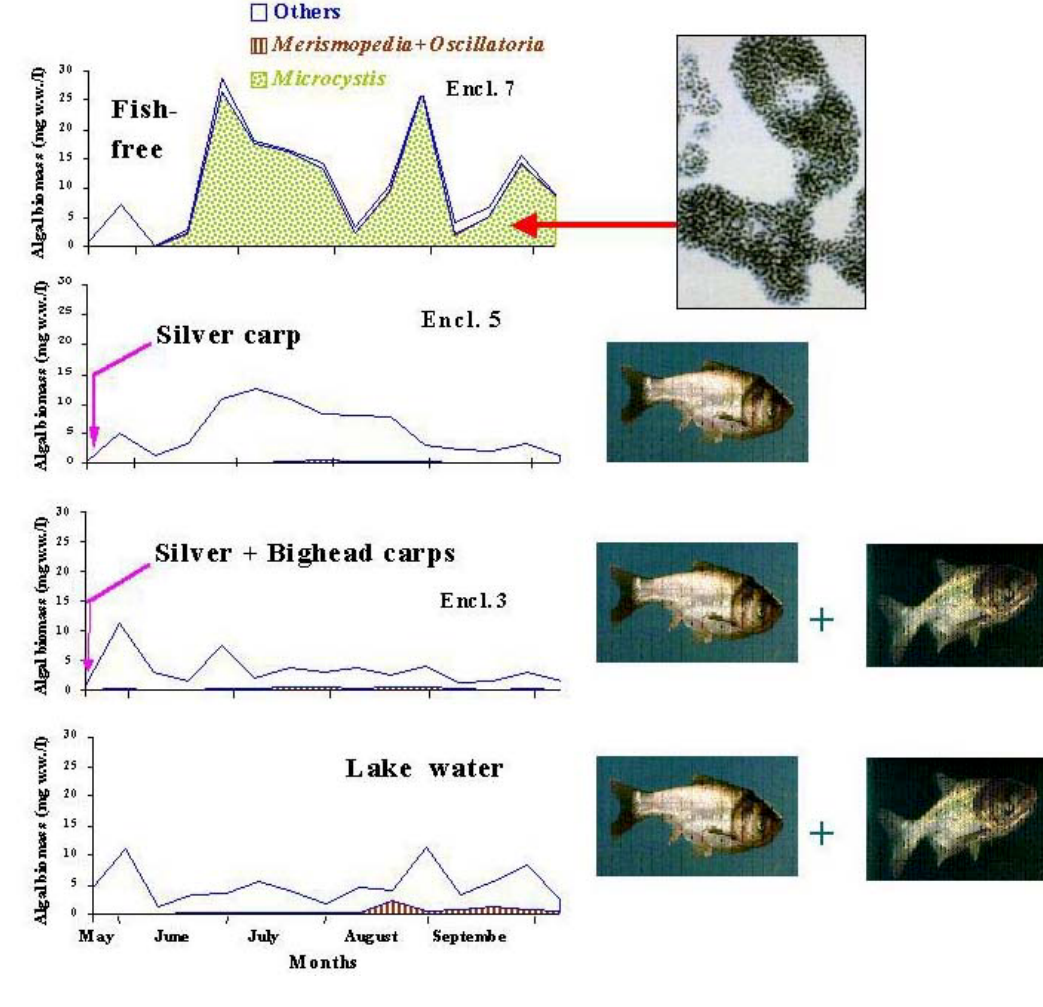
FIGURE 9. Changes in the biomass of Microcystis and other phytoplankton in the enclosures and the surrounding lake water in Lake Donghu during May-October, 1989 (adapted from Xie and Liu[14]).